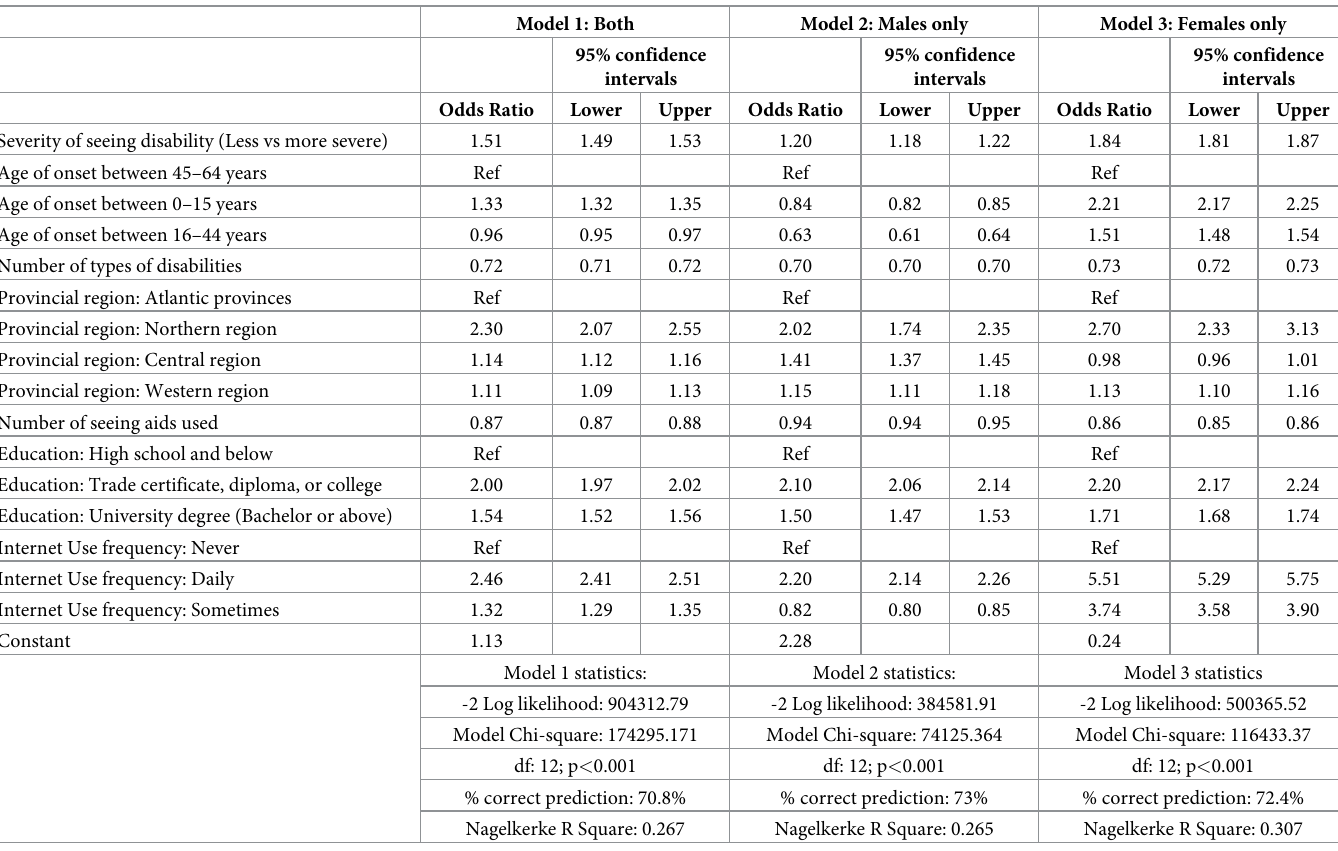
Table 3. Logistic regression model for predictors of employment for adults (25–64 years) with seeing disability in Canada, 2017 (N =